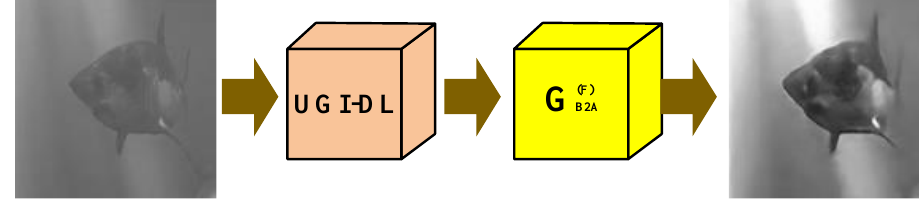
Figure 4. UDGI-FS consists of UGI-DL and G (F)